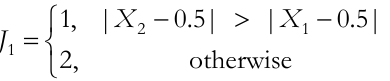
Values of E( ) Q for different values of 2 With ranking errors Without ranking